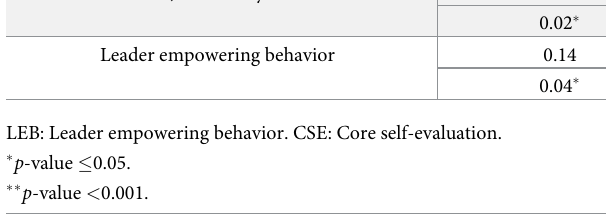
Table 3. Pearson correlation coefficient between CSE, LEB, and job security among nurses (N = 214). Variable